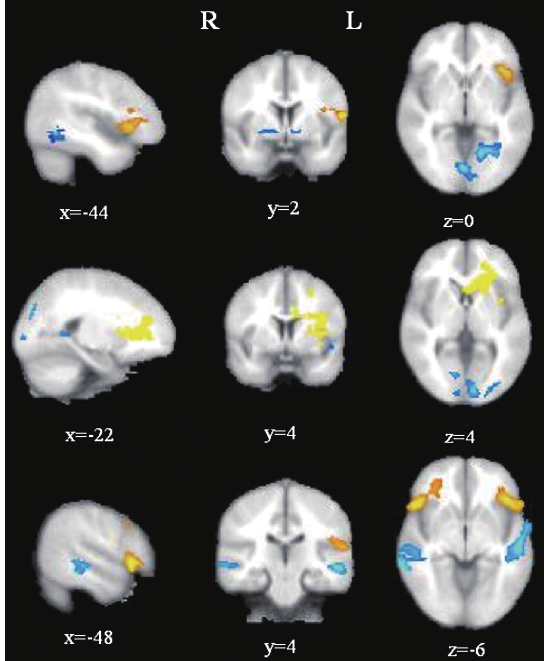
Fig. 3. Age-related activations visual (top), verbal (middle) and audi- tory (bottom) working memory tasks. Hot colors (red-yellow) point to positive activations and cold colors (blue-cyan) negative activa- tions for each contrast. Sagittal sections show left hemisphere. All maps are thresholded at a whole-brain corrected P < 0.05 using cluster-wise P < 0.05. For details see Table